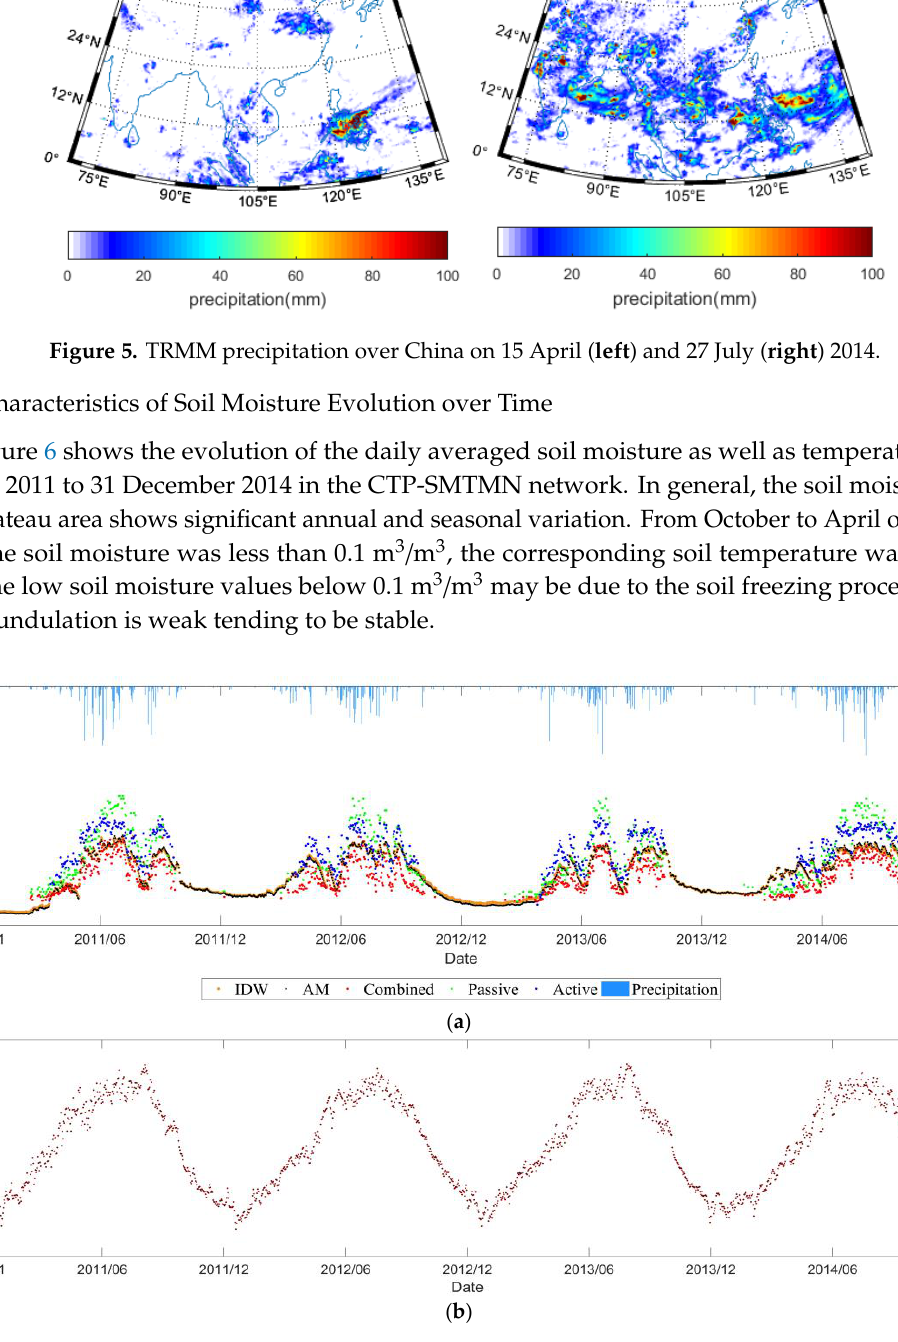
Figure 4. Extracted soil moisture retrieved from ( a ) active ( b ) passive ( c ) combined microwave signals over China on 15 April (left) and 27 July (right) 2014.